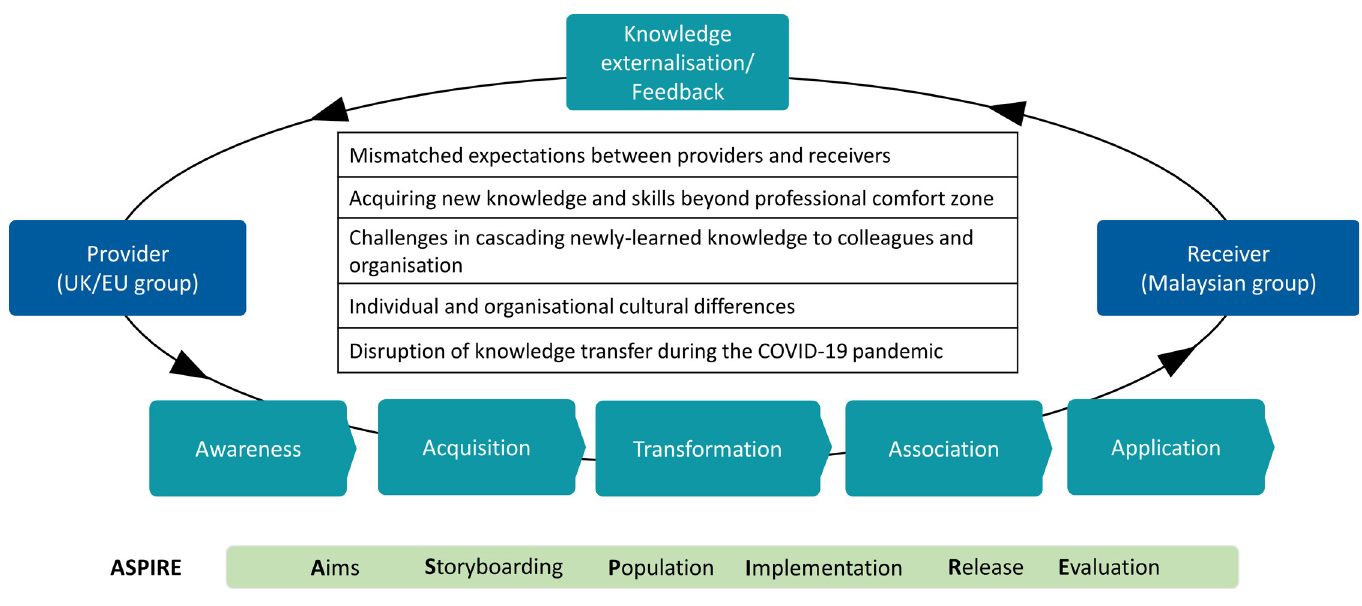
Fig 2. Challenges related to knowledge transfer of the ASPIRE